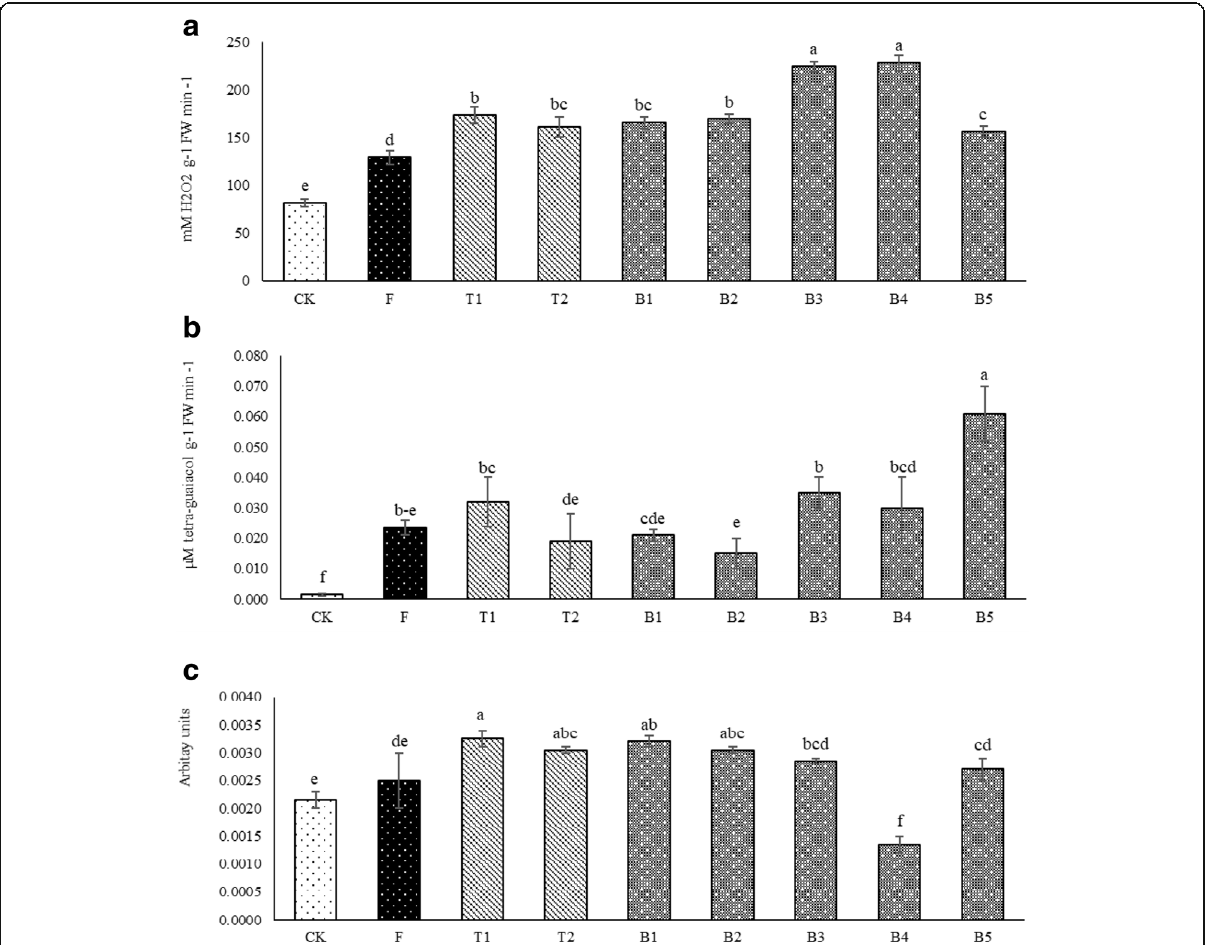
Fig. 3 a Activities of catalase (CAT), b peroxidase (POX), and c polyphenol oxidase (PPO) enzymes in squash leaves infected with powdery mildew after 24 h of treatments with bio-agents. CK, control; F, fungicide (Topas-100), T 1 , Trichoderma harzianum ; T 2 , T. viridi ; B 1 , Bacillus subtilis ; B 2 , B. chitinosporus ; B 3 , B. pumilus ; B 4 , B. megaterium ; and B 5 , B.